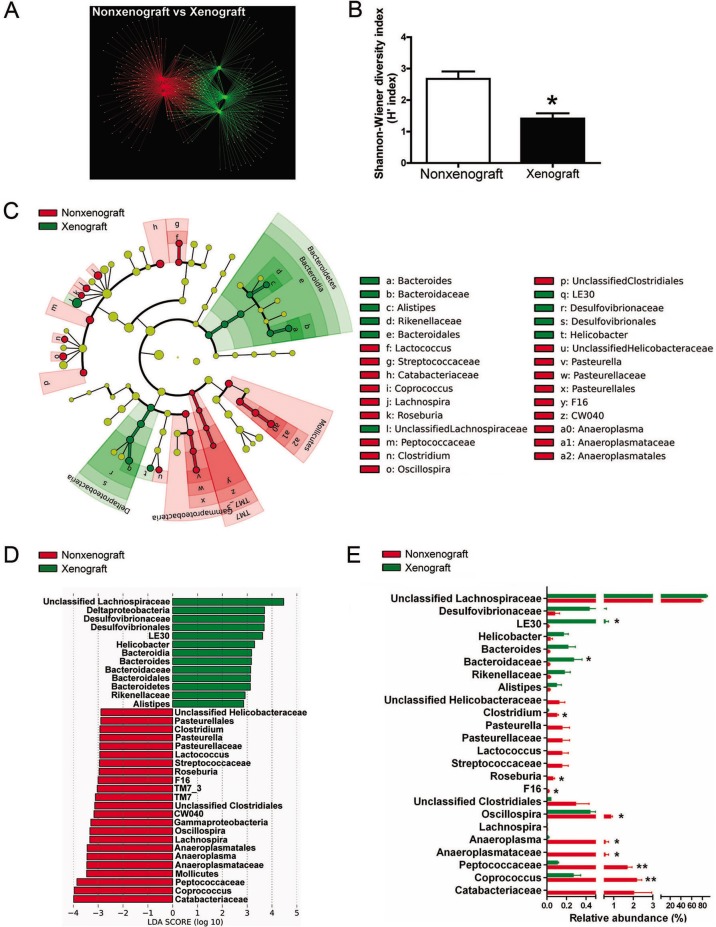
Pyrosequencing analysis of fecal microbiota of nonxenograft and xenograft nude mice.(A) Comparisons of overall OTU networks of fecal microbiota between the nonxenograft (red) and xenograft (green) mice. (B) Shannon-Wiener diversity index (H'). The analysis is based on the percentage of classified OTUs of each sample. H' index was used to calculate the diversity of microbial communities. H' = ∑ - (Pi * ln Pi). (C) Taxonomic representations of fecal microbiome of nonxenograft and xenograft nude mice. The differentially abundant taxa are presented with designated colors using LEfSe method. The taxa from nonxenograft and xenograft mice are colored in red and green, respectively. The taxa with nonsignificant changes between the nonxenograft and xenograft mice are colored in yellow. Each small circle’s diameter represents the taxon abundance. (D) Histogram of the LDA scores of fecal 16S rRNA gene sequences of nonxenograft (red color) and xenograft (green color) mice. LDA scores characterized the magnitude of differential abundance in the microbial taxa between compared samples. (E) The relative abundance (%) of differentially abundant families and genera. Nonxenograft nude mice, n = 3; Xenograft nude mice, n = 3. Data are presented as the mean ± SEM (* P < 0.05, ** P < 0.01, nonxenograft versus xenograft group).